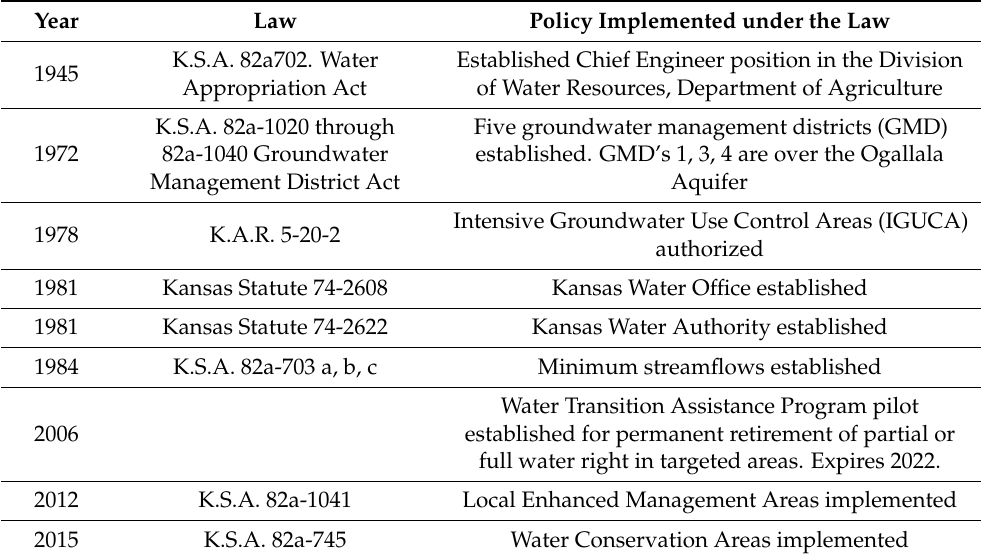
Table 1. History of water law and associated policy in